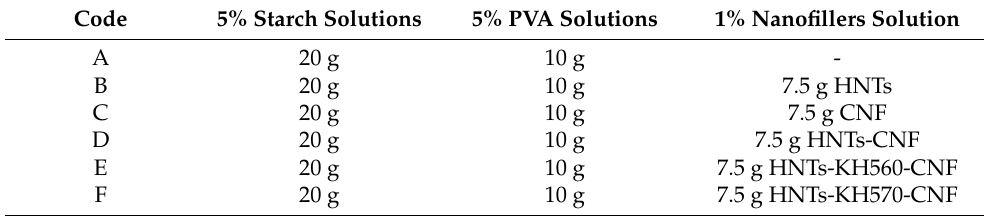
Table 1. The detailed code and formulations of all the composite membranes.